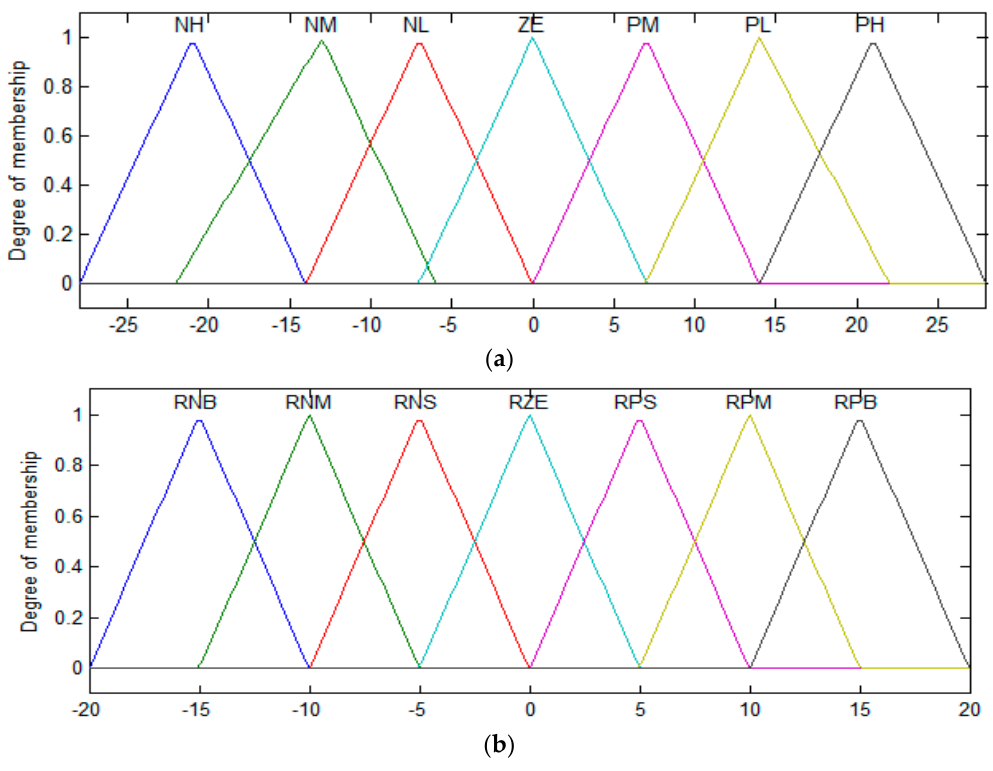
Figure 7. Membership functions for temperature fuzzy controller. ( a ) Input (cid:1857) (cid:1846) , ( b ) output RPT.